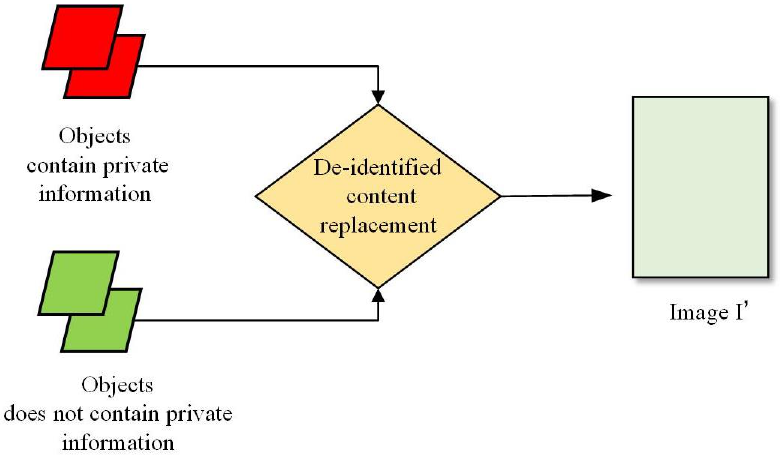
Figure 8. The diagram of de-identified content replacement part in our image de-identification (DE-ID)